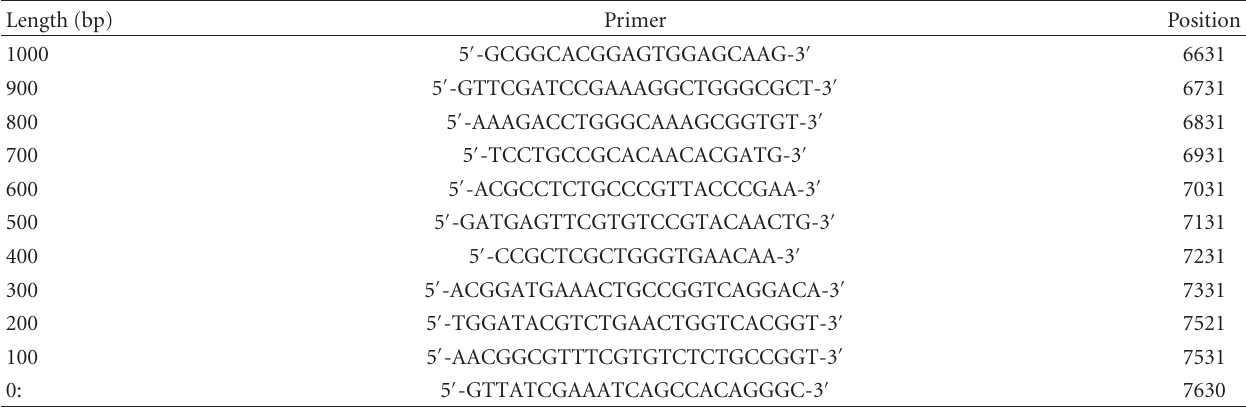
Table 1: Primers used in the